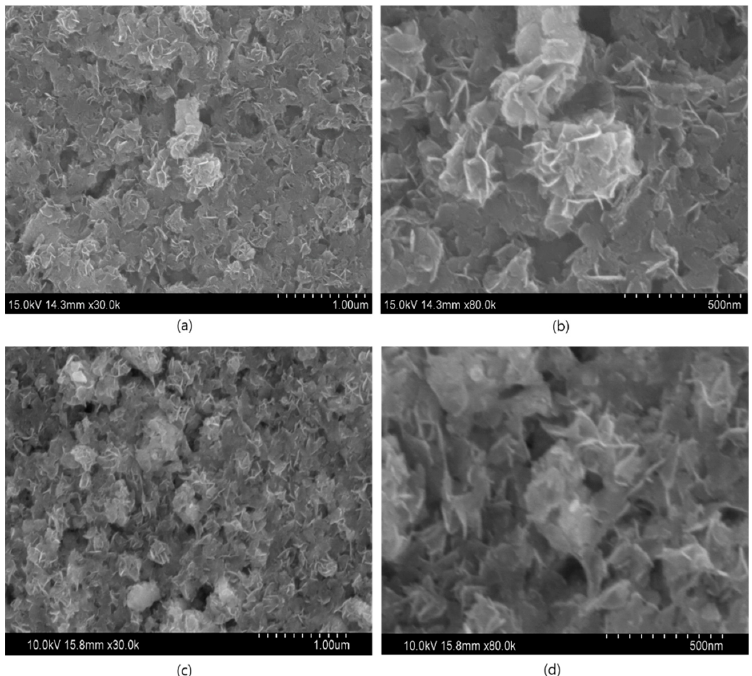
Figure 2. Field emission scanning electron microscopy (FESEM) images ( a , b ) SnO 2 nanoflakes ( c , d ) Ag QDs/SnO 2 nanostructures.